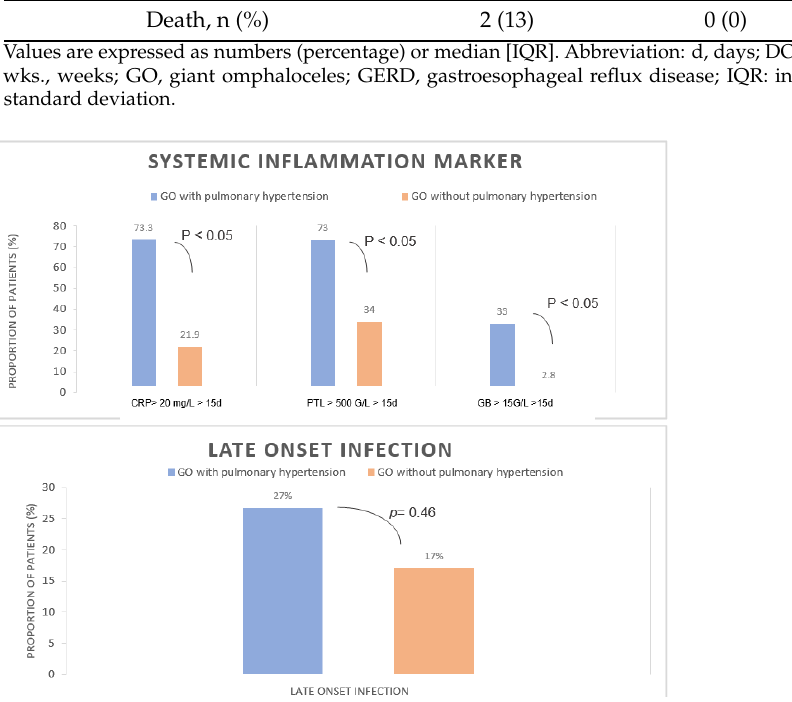
Figure 2. Comparison of systemic inflammation markers in GO with and without PH onset. Com- parison of late-onset infection between GO with PH and GO without PH. Abbreviations : CRP, pro- tein C-reactive; WBC, white blood cell; d, days; GO, giant omphalocele; PLT, platelet.